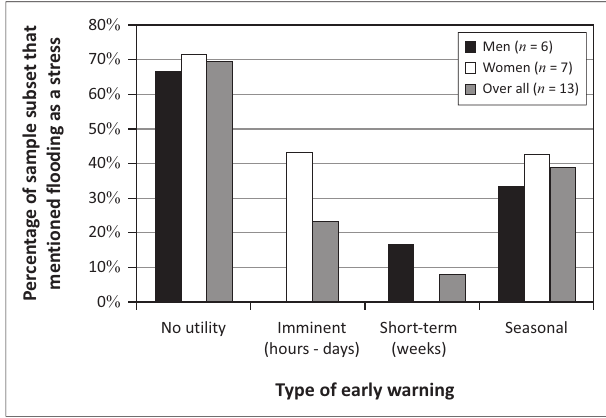
FIGURE 14: Livelihoods activities by gender in Group S.